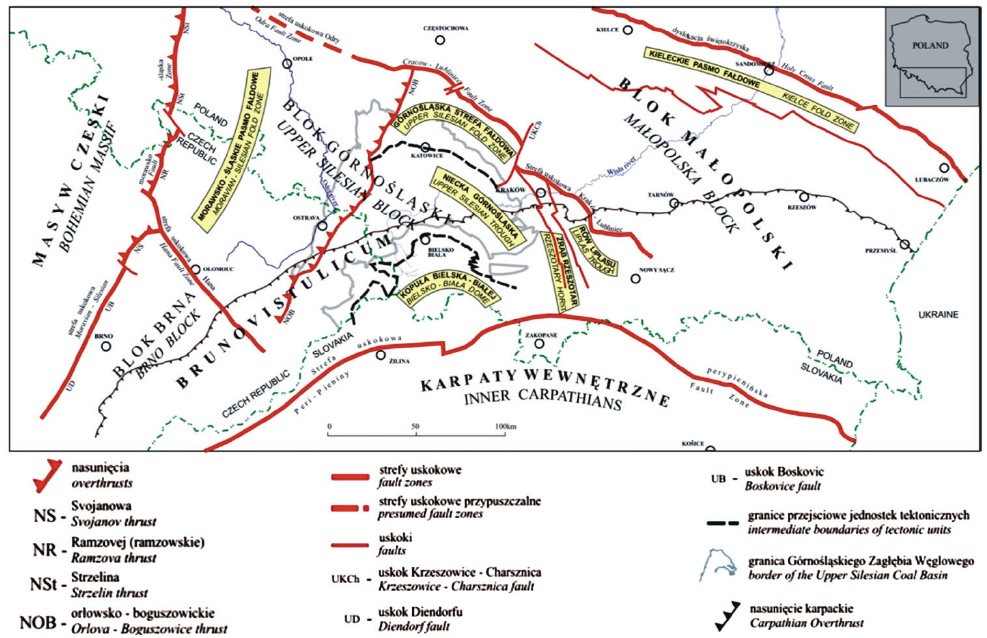
Fig. 1. The outline of the structural units of Upper Silesian Coal Basin (Buła, Żaba, Habryn,